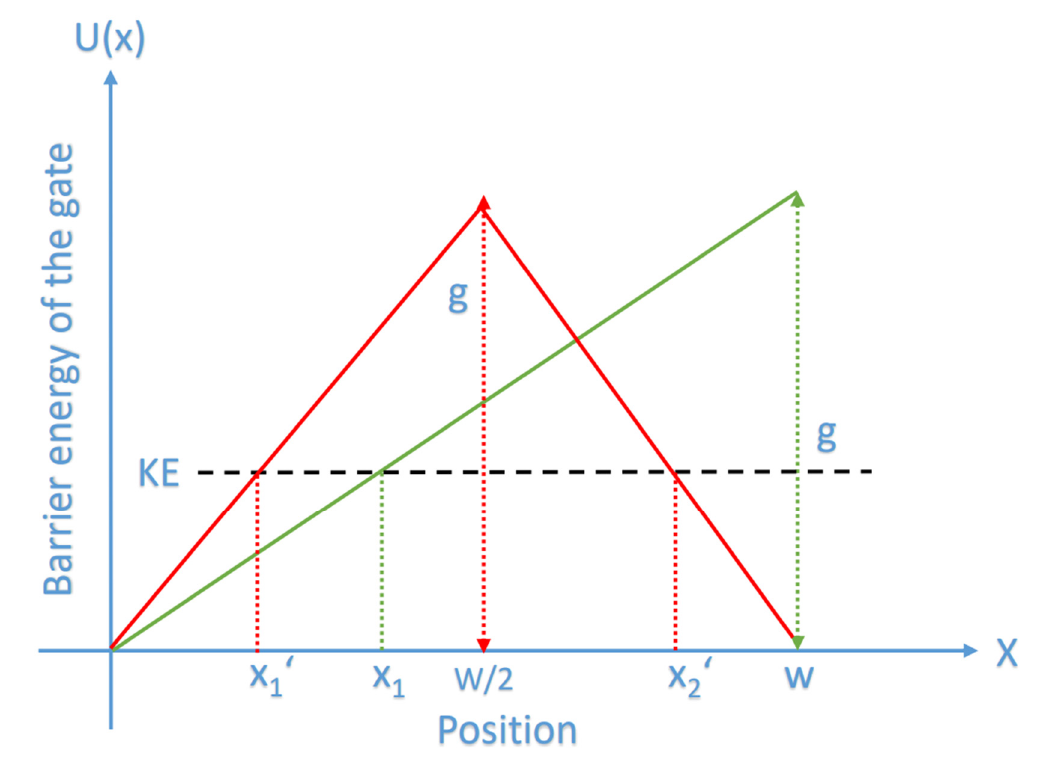
Figure 1. The figure represents a schematic diagram of two possible shapes of the energy barrier of the gate with respect to the ion’s position x through the gate. The green curve represents a triangle energy barrier in which the energy increases linearly till the end of the gate reaching the maximum energy value g similar to the energy barrier of the regular electric field, while the red curve represents a triangle barrier that shows a symmetry at the center similar to what observed experimentally in the hydrophobic materials. The red curve describes a linear increase in the energy of the gate till reaching the center where it reaches the maximum value g and then it starts to decrease by the same rate till the end of the gate. x 1 is where the kinetic energy of the ion equals the barrier energy at the green curve, while x 1 ′ and x 2 ′ are the ion’s positions where the kinetic energy of the ion equals the barrier energy on the red curve.